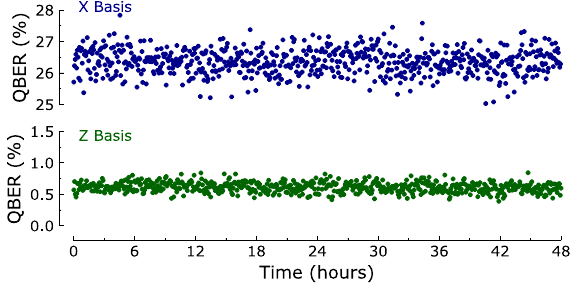
Fig. 4 MDI-QKD system stability. Measured QBER in X -basis and Z - basis showing long-term